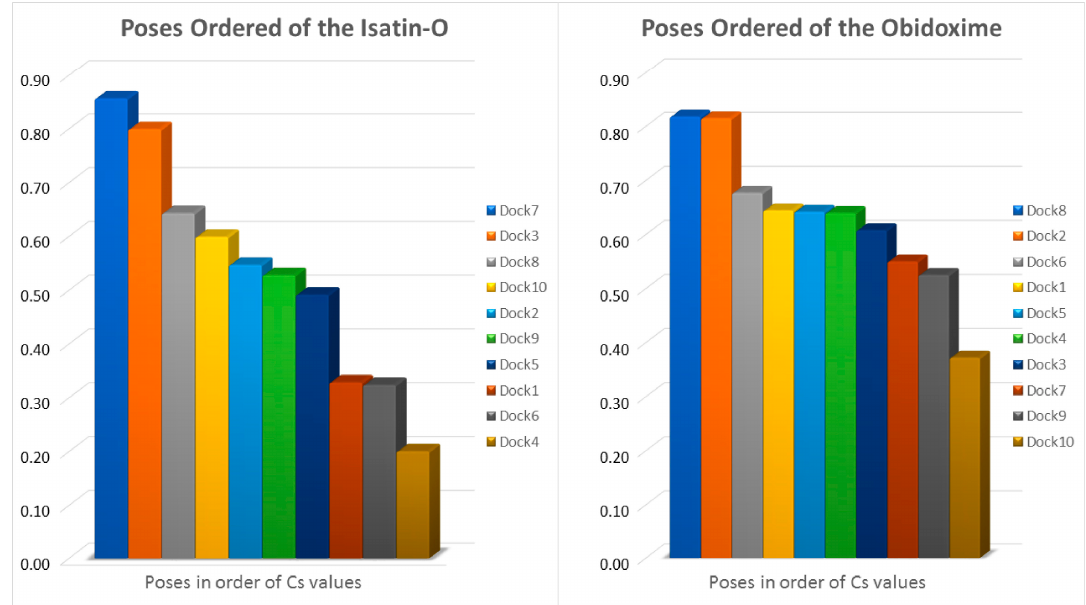
Figure 7. Results for the evaluation of poses through the hybrid MCDM TOPSIS-AHP method. ( Left ): Isatin-O; ( Right ): Obidoxime.